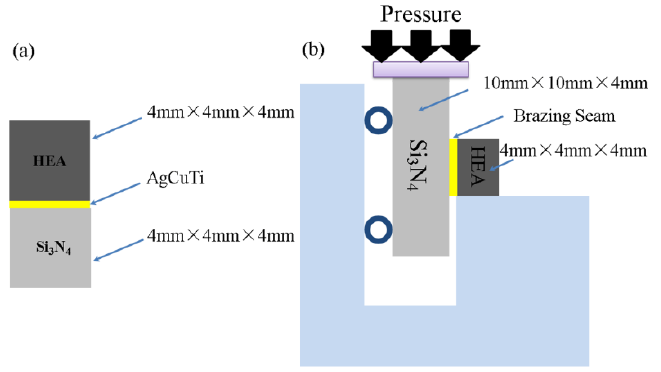
Figure 1. Schematic diagram of ( a ) brazing assembly and ( b ) shear test.